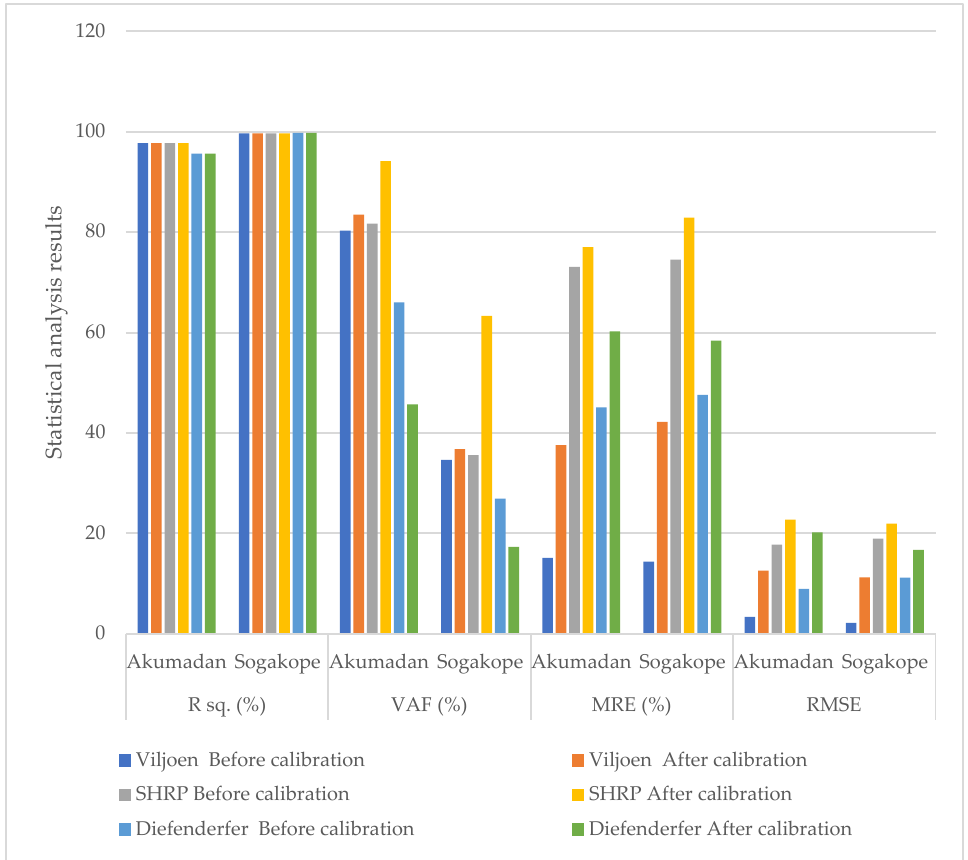
Figure 3. Statistical analysis results of the effect of geographical location on both calibrated and uncalibrated models.